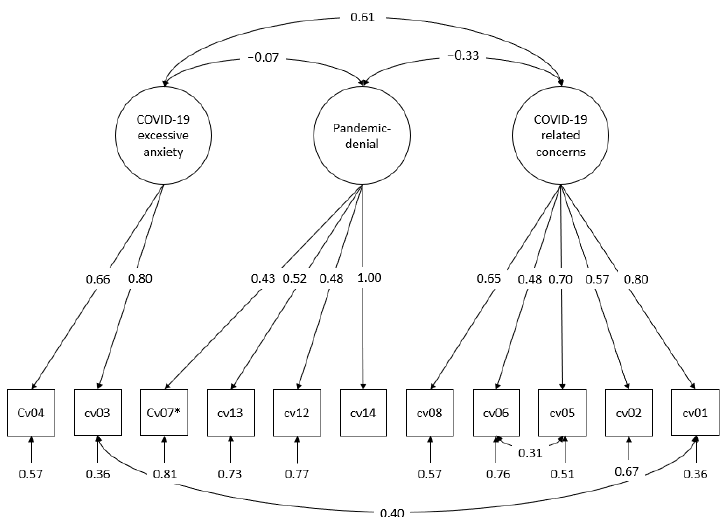
Figure 1. Standardized solution of the simultaneous confirmatory factor analysis for the dimensions of COVID-19 attitudes, MLR estimation. χ 2 = 82.287 (df = 40, p < 0.001), RMSEA = 0.057, CFI = 0.952, TLI = 0.934, SRMR = 0.054. cv01: I am afraid of becoming infected with COVID-19; cv02: I feel like I have little control over whether or not I get infected with COVID-19; cv03: I feel like I would not survive a COVID-19 infection; cv04: I feel like I have to give up because of COVID-19; cv05: I am afraid of infecting others with COVID-19; cv06: My family and friends are afraid that they will get infected by me with COVID-19; cv07 *: The German government has done the right things in dealing with COVID-19; cv08: COVID-19 worries me; cv12: COVID-19 is not much worse than the annually recurring flu; cv13: The actual background of the COVID-19 disease will never come to light; cv14: The COVID-19 crisis has been talked about in such a way that few can benefit from it. * The item has been inverted so that high values represent a negative attitude. Observed variables are represented by rectangles and latent variables by circles. Arrows directed from the latent factors to the measurement indicators represent factor loadings. Arrows directed at measurement indicators without “emitting” variables represent the measurement error of the respective indicator. Curved two-directional arrows correspond to undirected relationships, i.e., covariances or correlations ei- ther between latent factors or between measurement errors. Standardized factor loadings greater than or equal to 0.30 or 0.40 can be interpreted as salient [40].